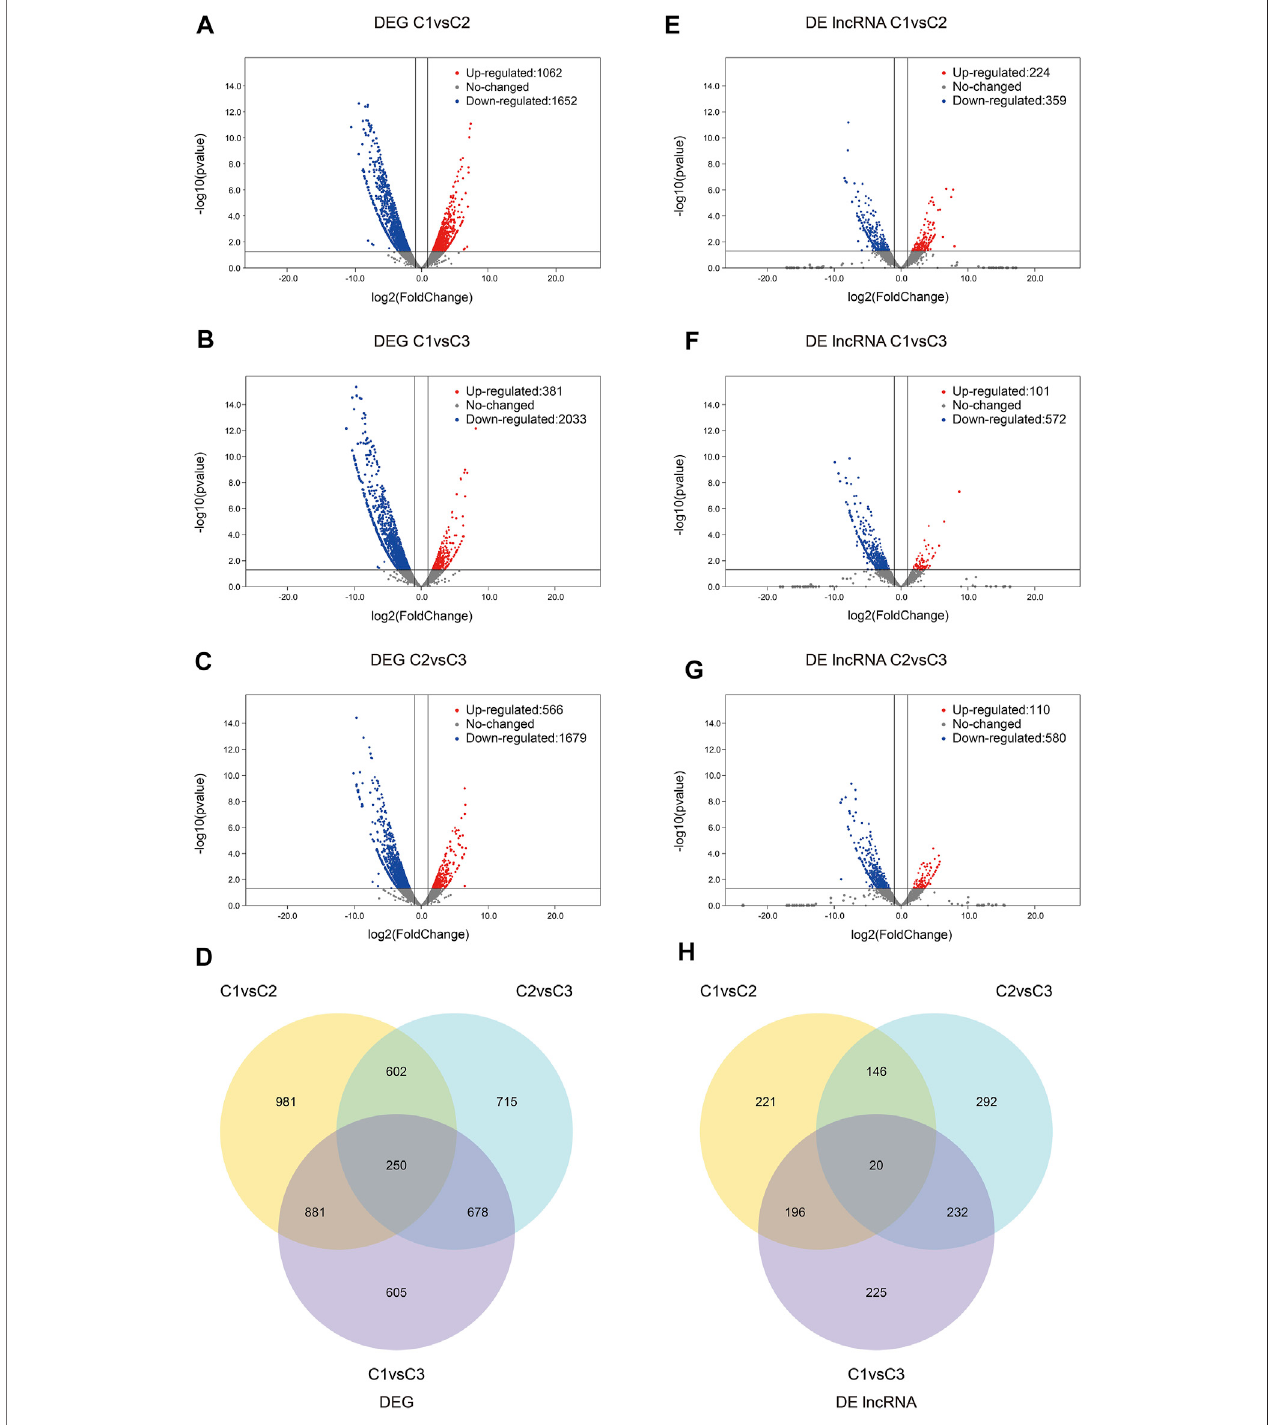
FIGURE3| ThedifferentialexpressionofgenesandlncRNAs. (A – C) VolcanoplotsofDEGscomparingC1vsC2,C1vsC3,andC2vsC3,respectively.Up-regulated genes were indicated byred dots, down-regulated genes were indicated by blue dots, and grey dots indicated constitutively expressed genes. (D) Venn Diagrams of all compared DEGs. (E – G) Volcano plots of the DE lncRNAs comparing C1vsC2, C1vsC3, and C2vsC3, respectively. Red and blue dots represented up- and down- regulated DE lncRNAs, respectively. The non-DE lncRNAs were represented by grey dots. (H) The Venn diagrams of the DE lncRNAs of all comparisons. C1, undifferentiated stage; C2, differentiation stage; C3, differentiation complete stage; DE, differentially expressed; DEG, differentially expressed gene.